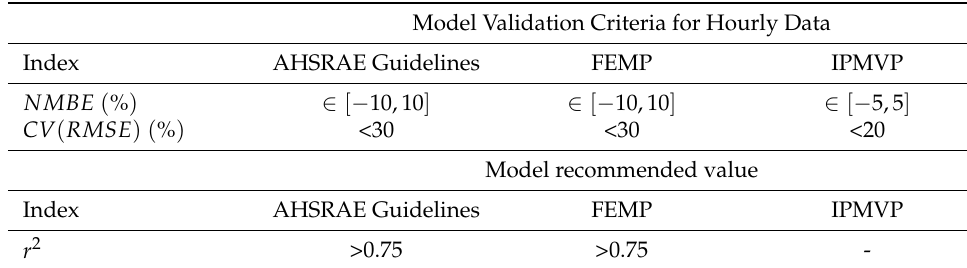
Table 5. Model validation criteria of ASHRAE Guideline-12, FEMP and IPMVP. Model Validation Criteria for Hourly